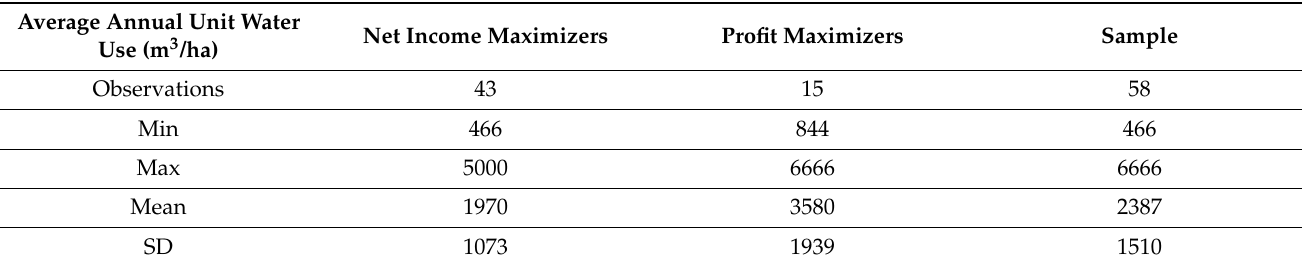
Table 6. Irrigation water